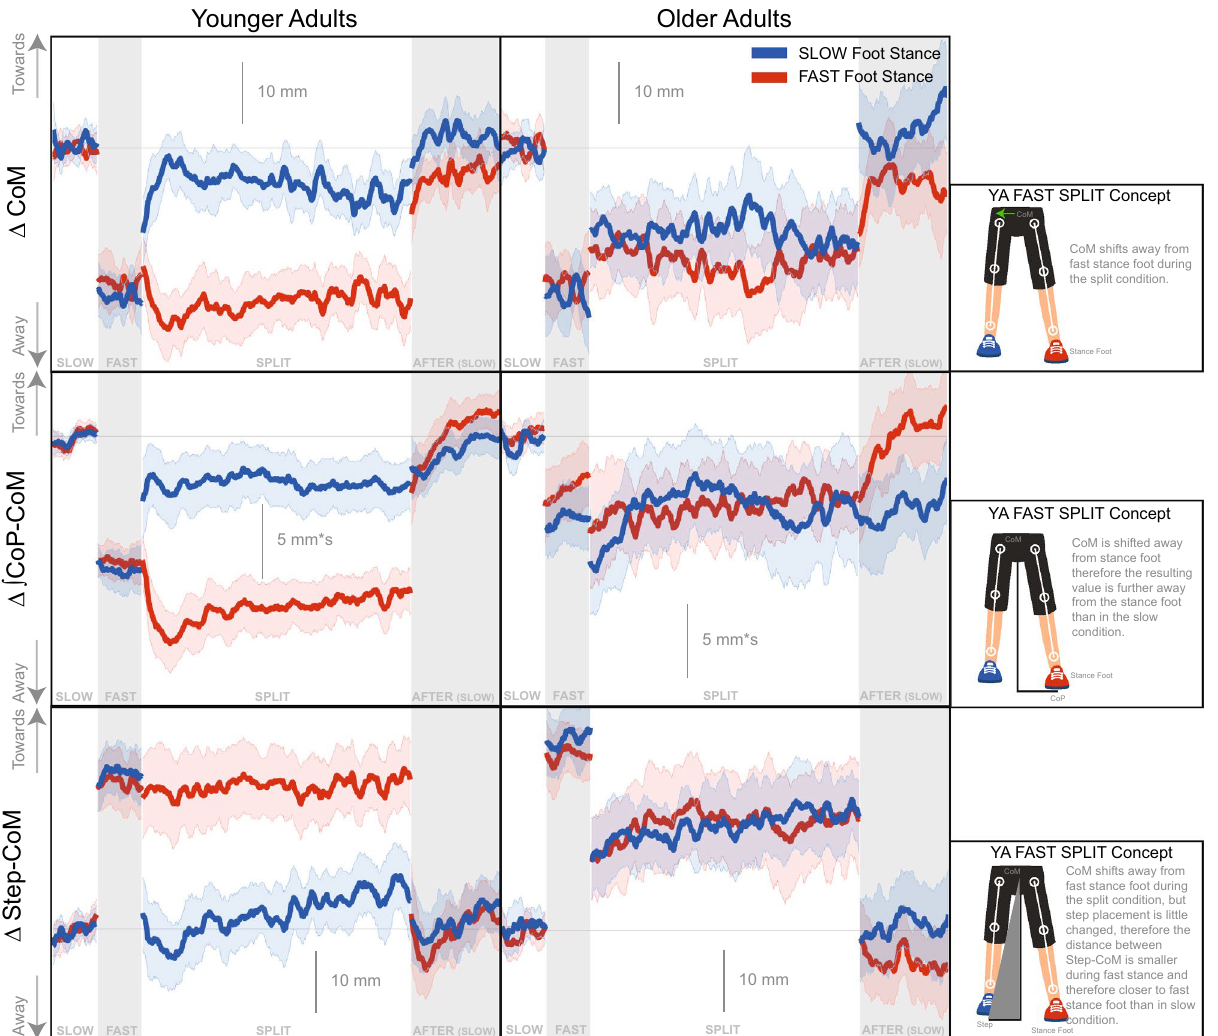
Figure 3. CoM Referenced Gait Parameters adaptation time series graphs for younger (left column) and older (right column) adults. The time-series data were smoothed with a 2 step sliding window moving average for display purposes. The blue data corresponds to the right foot, and the foot that made contact with the slow belt during split condition. The red data corresponds to the left foot, and the foot that made contact with the fast belt during split condition. The bolded lines indicate the group mean. The shaded areas represent the 95% confidence interval of the group mean. All values are represented as a change from the average of the slow condition ( (cid:31) ). Towards refers to in the direction of the stance